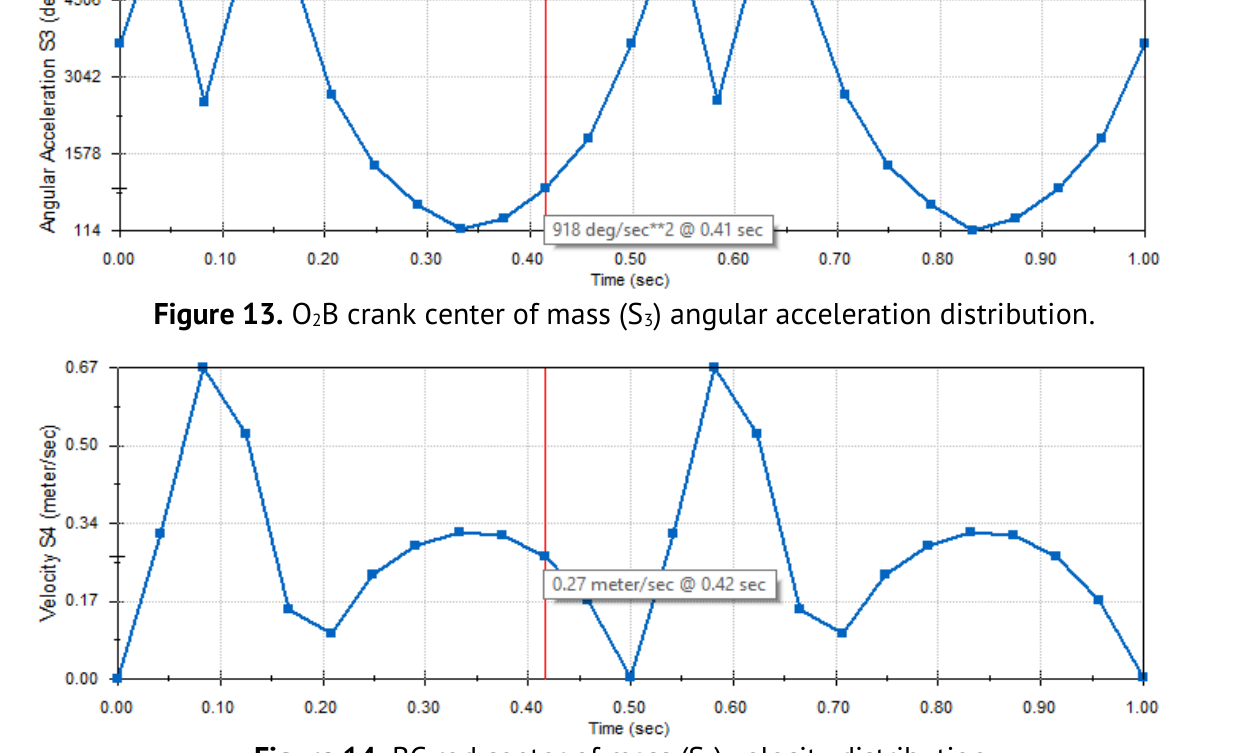
Figure 14. BC rod center of mass (S